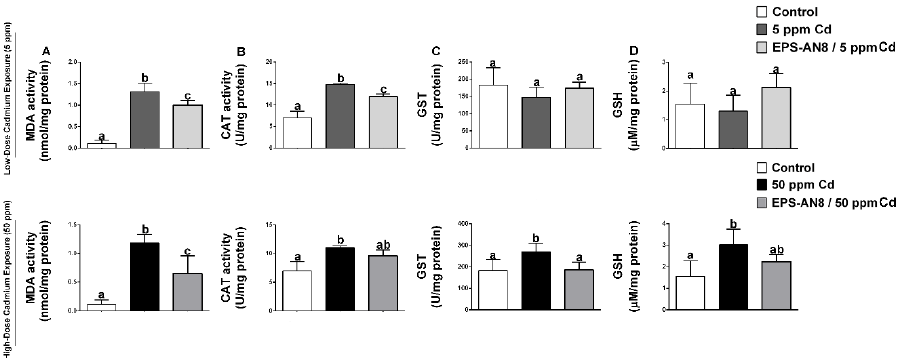
Figure 3. The protective effect of EPS-AN8 on Cd-induced oxidative stress are expressed via ( A ) MDA, ( B ) the acitivity of enzyme catalase, ( C ) the activity of glutathione-S-transferase, ( D ) the level of reduced glutathione. Results are presented as mean ± SD. Values that do not share a common letter are significantly different ( p < 0.05).